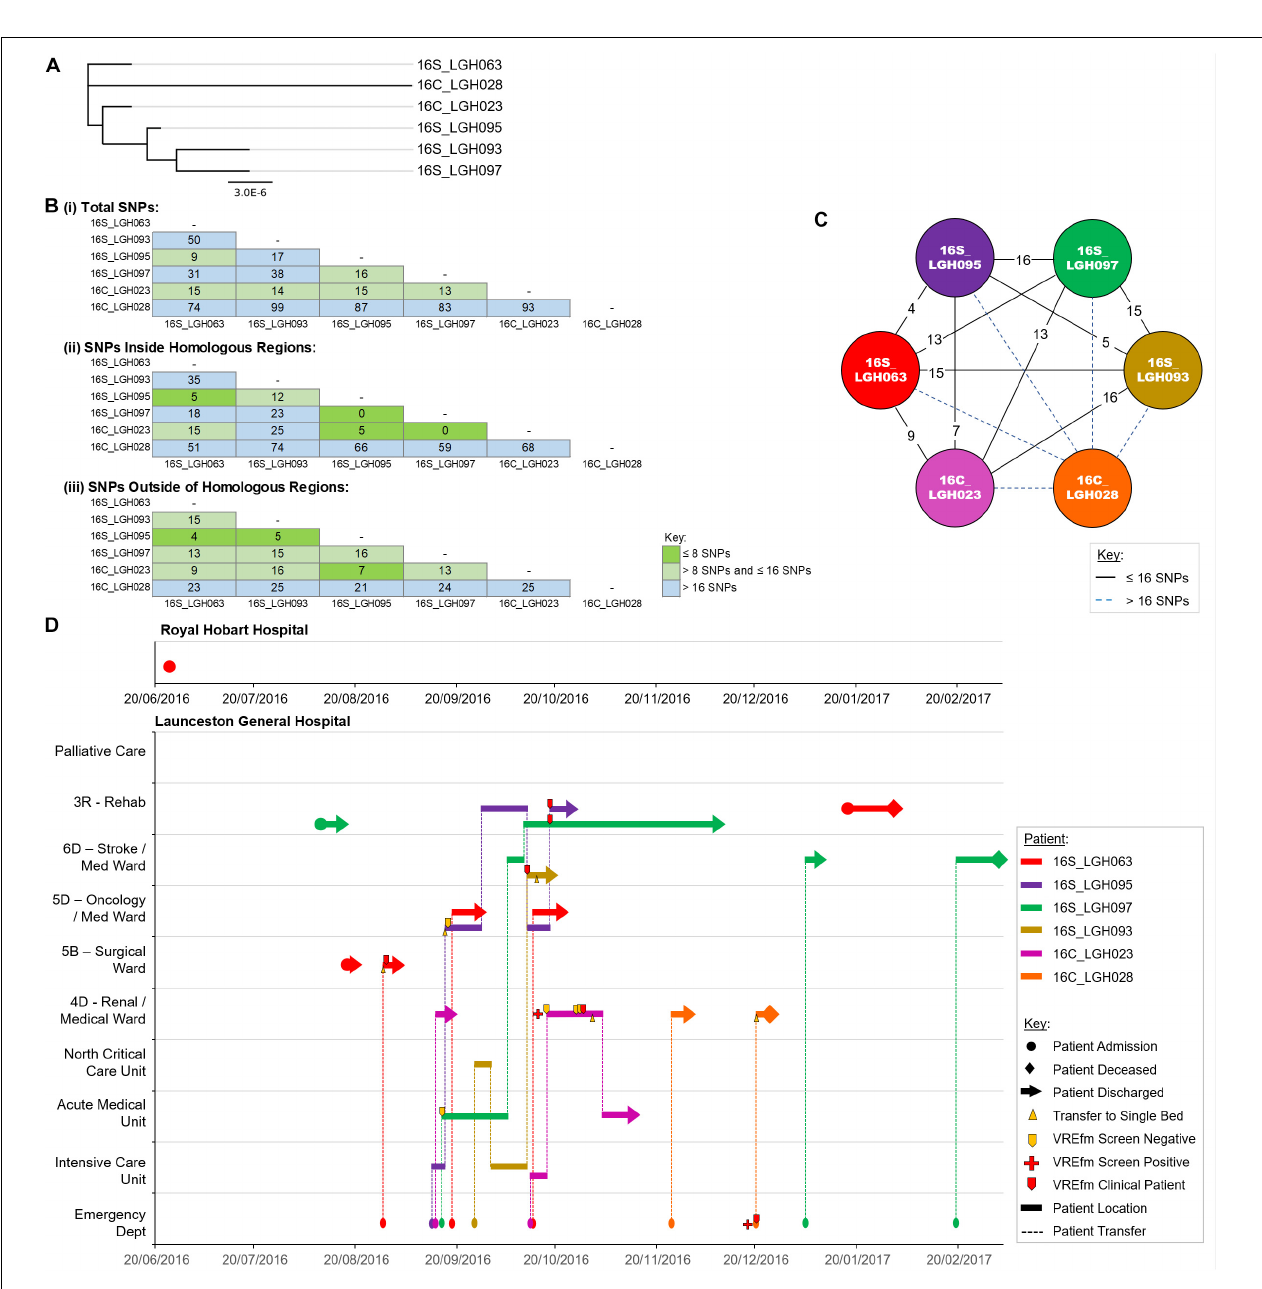
FIGURE 6 | Phylogenetic analysis of vancomycin-resistant Enterococcus faecium (VREfm) isolates from ST1421 Cluster 2. (A) A SNP-based maximum-likelihood (PhyML) phylogenetic tree. (B) Matrix of pairwise comparison of SNP differences between isolates expressed as: (i) Total number of SNP differences; (ii) Number of SNPs inside homologous recombination regions, and (iii) Number of SNPs outside of homologous recombination regions. The previously described recombination-filtered SNP threshold of ≤ 16 SNPs for VREfm has been used as a guide for identifying clonally related or non-unique isolates. (C) Overview of recombination-filtered SNPs between isolates. The numbers of different SNPs between the isolates are shown on the solid black connecting lines. SNP differences above the threshold of 16 SNPs are shown as blue dotted lines. (D) Spatio-temporal location of patients in Cluster 2 who tested positive for VREfm at the Launceston General Hospital. The movement of patients following admission to hospital through to date of discharge are indicated with respect to time ( x -axis) and hospital ward location ( y -axis). Each line color represents an individual patient. As illustrated, patient 16S_LGH063 had admissions to both the Royal Hobart Hospital and Launceston General Hospital but was confirmed VREfm positive at the latter